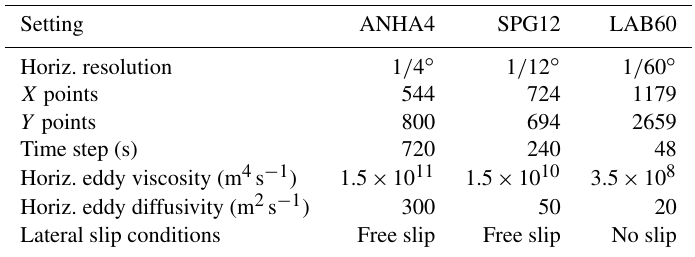
Table 1. Domain settings for the ANHA4 parent domain, the SPG12 nested domain, and the LAB60 nested domain. Other settings that are invariant to the domain are shown in Table